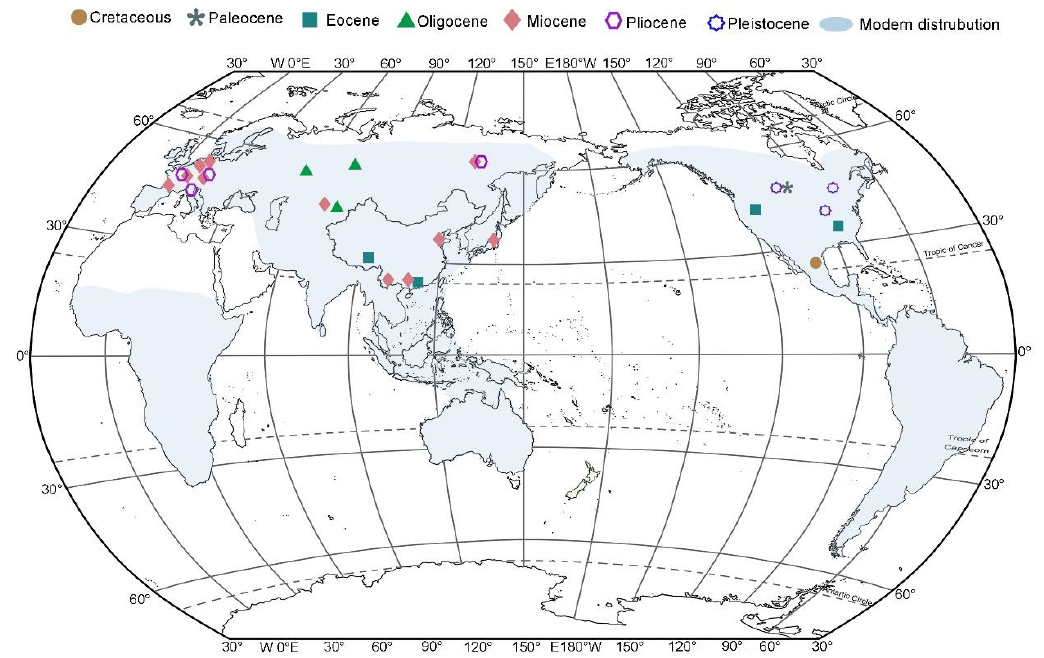
Figure 5. Geological distribution map of Ceratophyllum modern species, and fossil records.